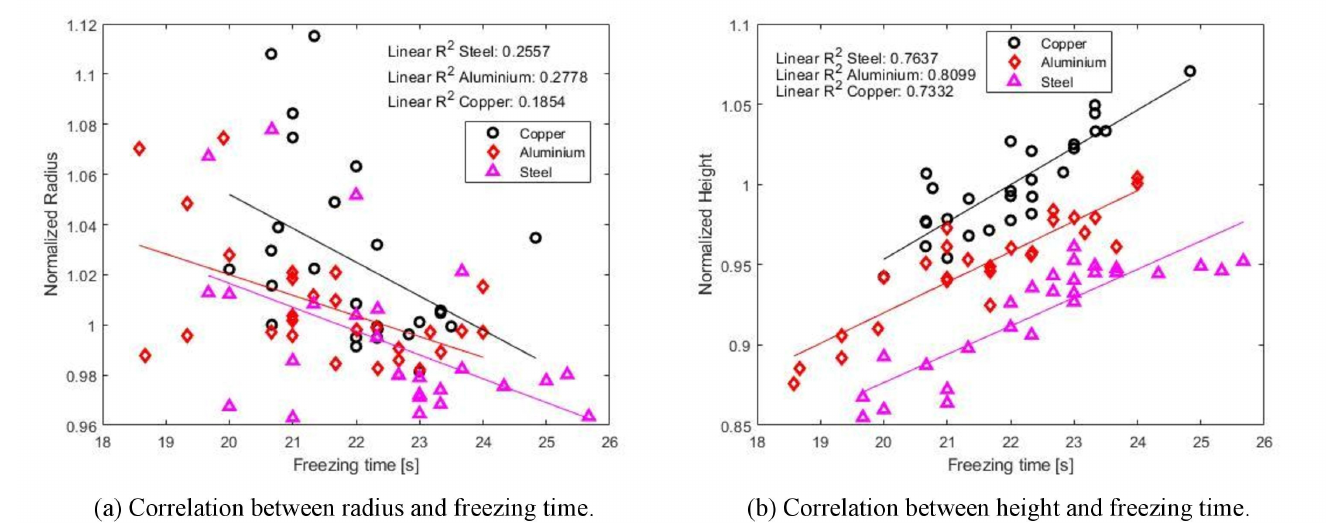
Figure 4. Droplet radius and height as a function of freezing time. ( a ) shows the normalized radius as a function of freezing time. ( b ) shows the normalized height as a function freezing